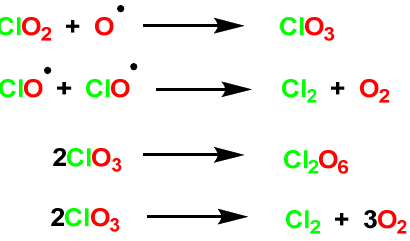
Figure 20. The photolysis of dry, gaseous ClO 2 . The degradation mechanisms and radical chemistry associated with UVC photolysis of ClO 2 are quite complicated[51]. The photolysis of ClO 2 by UVC light provides ClO − and oxygen by cleavage of the Cl ‐ O[52] and Cl • [53] bond, Figure 21.